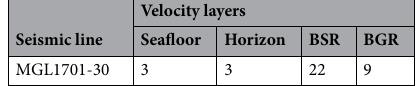
Table 2. Number of iterations.